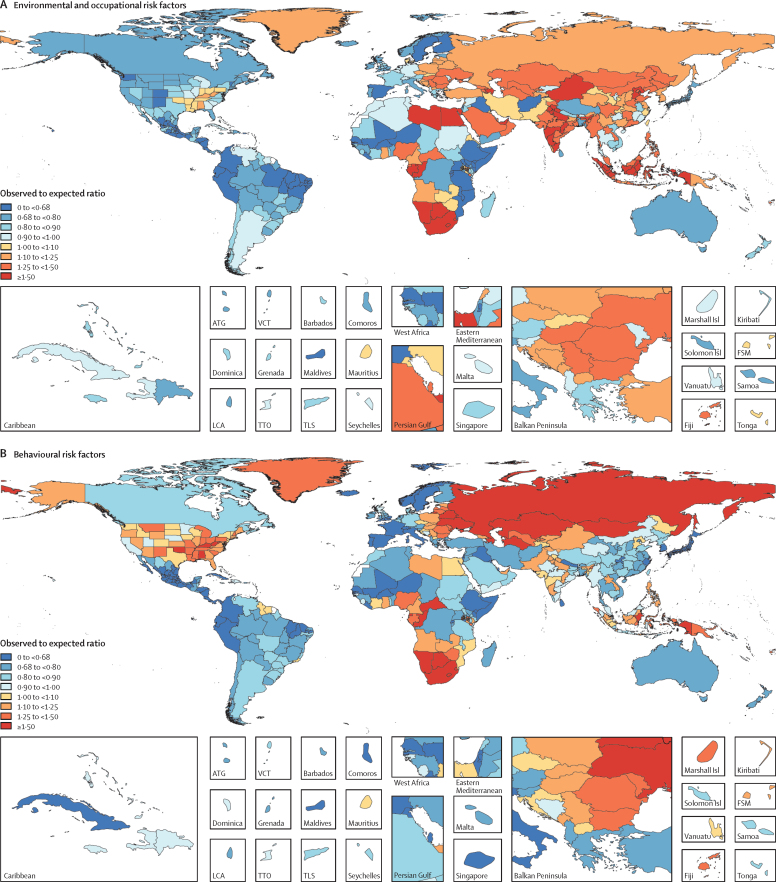
Ratios of observed to expected attributable DALY rates based on Socio-demographic Index for each Level 1 risk for both sexes by location, 2017Ratios for environmental and occupational risk factors (A), behavioural risk factors (B), and metabolic risk factors (C). Observed to expected ratios are based on age-standardised DALY rates.ATG=Antigua and Barbuda. DALYs=disability-adjusted life-years. FSM=Federated States of Micronesia. Isl=Islands. LCA=Saint Lucia. TLS=Timor-Leste. TTO=Trinidad and Tobago. VCT=Saint Vincent and the Grenadines.